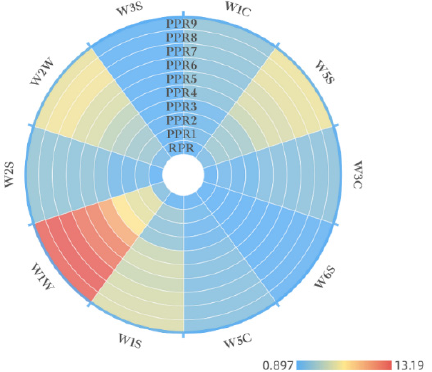
Figure 2. Odor characteristics of PR samples with different processing levels.